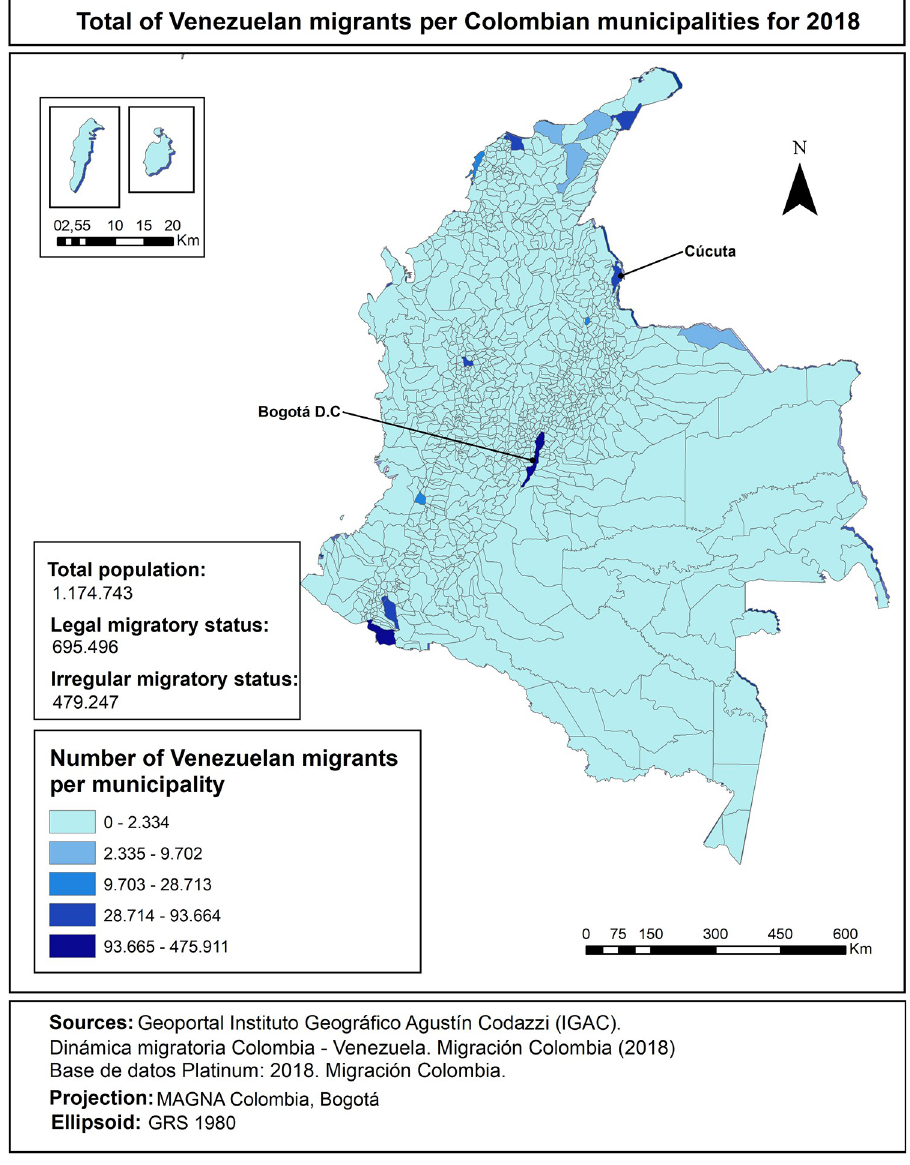
Fig 2. Venezuelan migrants per Colombian municipalities for